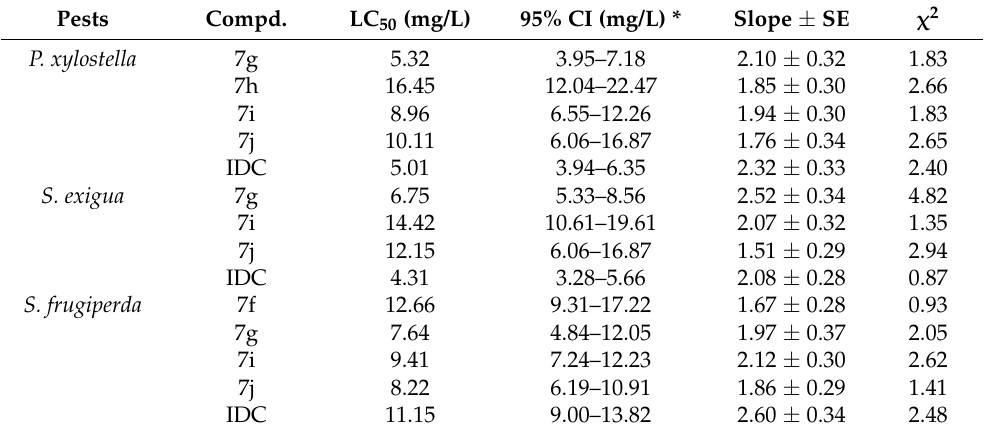
Table 2. LC 50 values of the target compounds against three Lepidoptera pests after treatment 48 h. Pests